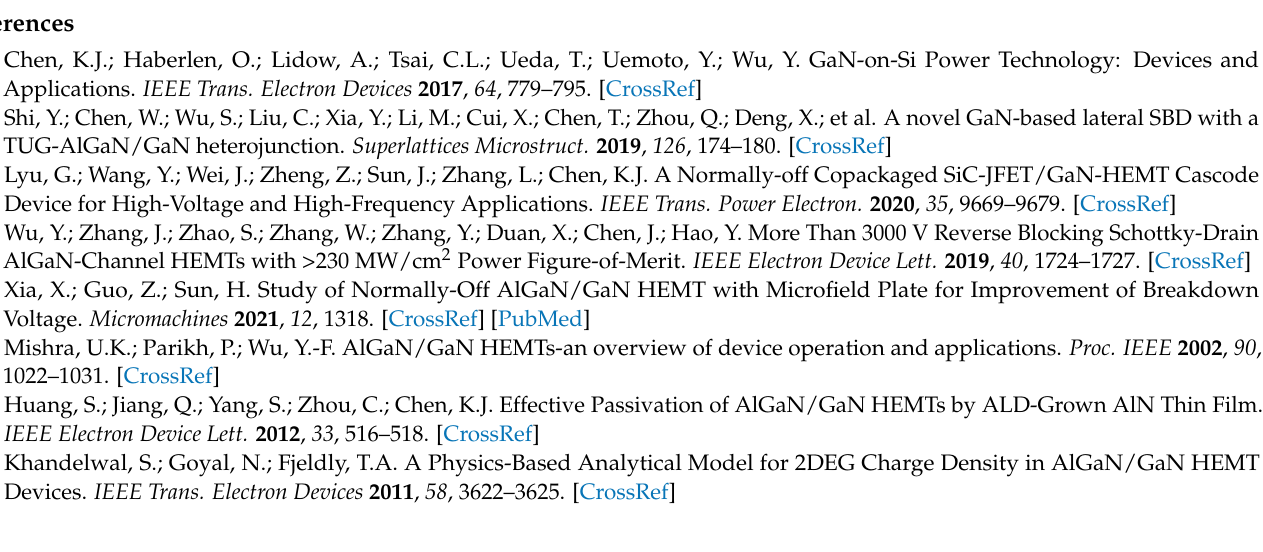
Figure 10. ( a ) Dependence of BV and FOM on the interface trap concentration of the AlGaN buffer region and Si 3 N 4 buried layer. ( b ) Vertical electric field at x = 6.0 µ m in the off state with a drain voltage of 600